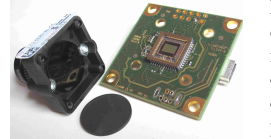
Figure 4: NIR camera with detached camera mount and neutral filter glass. The glass can be fixed inside the cam- era mount in addition to the present daylight cut filter.